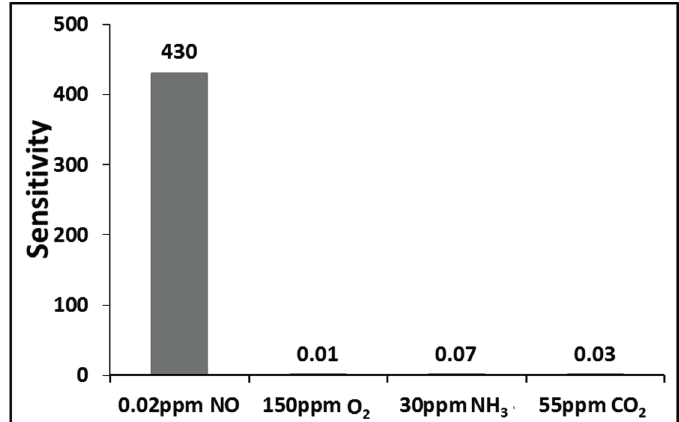
Figure 11. The responses of the sensor to NO gas at 20 ppb, O 2 gas at 150 ppm, NH 3 gas at 30 ppm, and CO 2 gas at 55